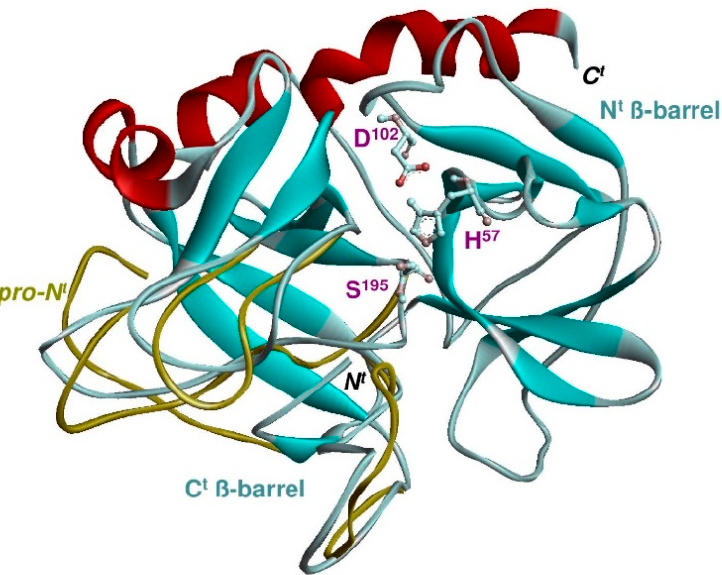
Figure 1. C α -main chain structure of a serine protease compared with its zymogen (light blue and yellow loops) showing the N- and C-terminal ß-barrels (cyan) with helices in red. The residues of the catalytic triad (His, Asp, and Ser) are shown as ball and stick models and map to the N t (His, Asp) and C t (Ser) ß-strand barrel. After removal of the N-terminal propeptide, the free N-terminus (N) of the mature enzyme (Ile16 to Gly19) inserts into a pocket of the zymogen and forms a salt bridge with Asp194 (chymotrypsinogen numbering). Extensive reorientation of three surface loops occurs in the so-called activation domain (yellow loops) within the C-terminal ß-barrel (C t ). The S1 pocket opens completely and can now bind the P1 side chain of the substrate. The specificity of the S1 pocket is determined by a few residues of the enzyme directly in contact with the side chain (adapted from [3]). The carbonyl carbon of the amide bond between the P1 and P1 (cid:48) residues is attacked by the polarized hydroxyl group of the Ser195. The N-terminal fragment of the substrate forms a transient covalent complex, while the C-terminal fragment of the substrate is released. A water molecule occupies a position just vacated by the N-terminal P1 (cid:48) residue of the leaving fragment. The latter hydrolyses the acyl-enzyme complex and releases the N-terminal fragment with P1 at its C-terminus. In canonical inhibitor complexes, the reactive site peptide bond remains intact or is slowly cleaved. By contrast, suicide inhibitors, i.e., serpins, form a distorted stable acyl-enzyme complex, in which water molecules cannot attack the acyl bond. In effect, many factors, preferential binding to an optimal substrate, rapid generation of the tetrahedral intermediate, the acylation, and the de-acylation reaction of the entire cycle determine the catalytic efficiency of the enzyme